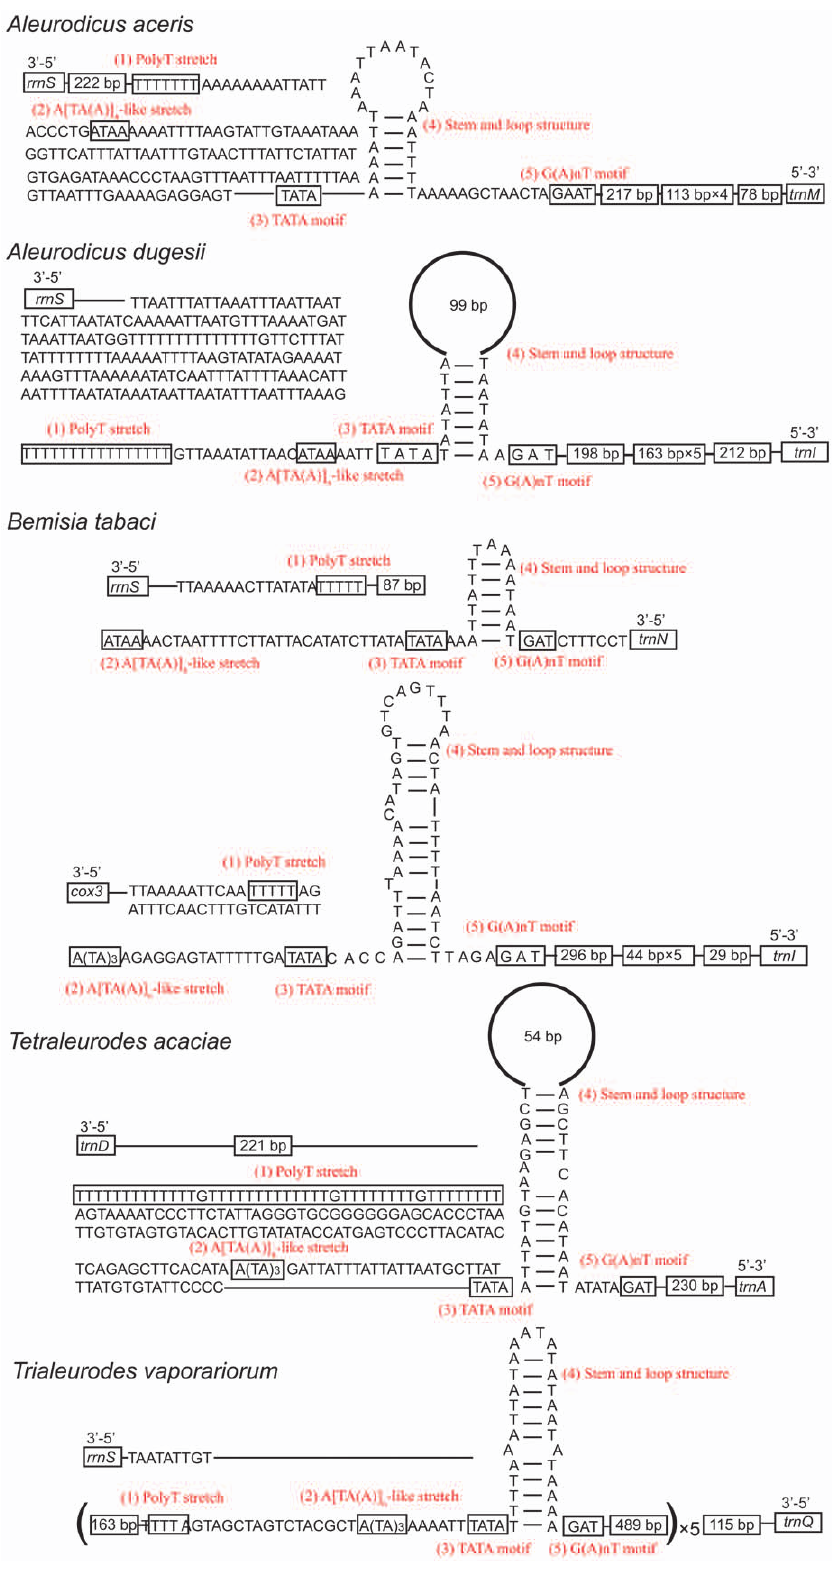
Figure 2. Predicted structural elements for A + T-rich region of 10 species with reversal of strand asymmetry.